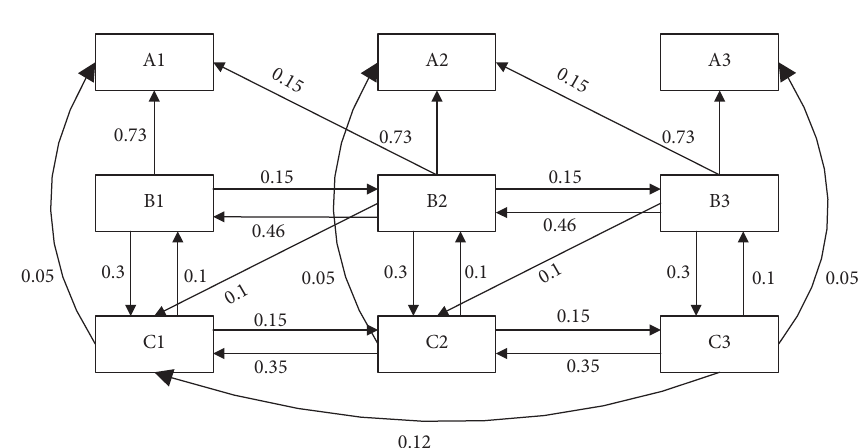
Figure 13: The diagram of spatial units in the upstream